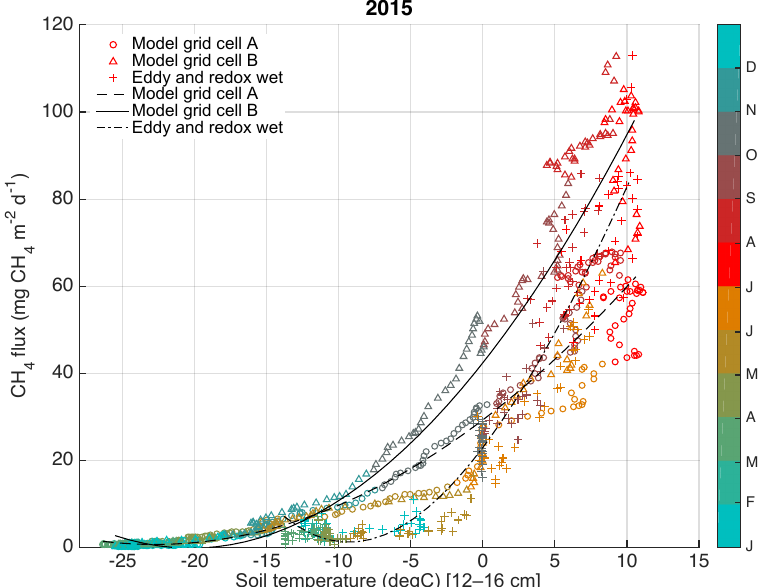
Figure 8. Model soil temperatures at 12cm depth and measured values at 16cm depth measured at a wet site, against the total methane emissions for grid cells A and B in